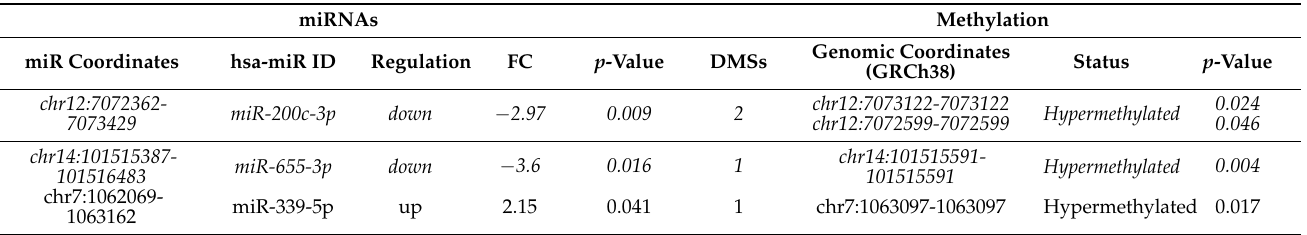
Figure 3. Heat maps of miRNA sequencing study. Green represents miRNAs with an expression level under the mean, while red shows miRNAs with an expression level above the mean. Table 3. Integrated analysis between miRNAs and methylation data in the comparison of CAD vs CTR